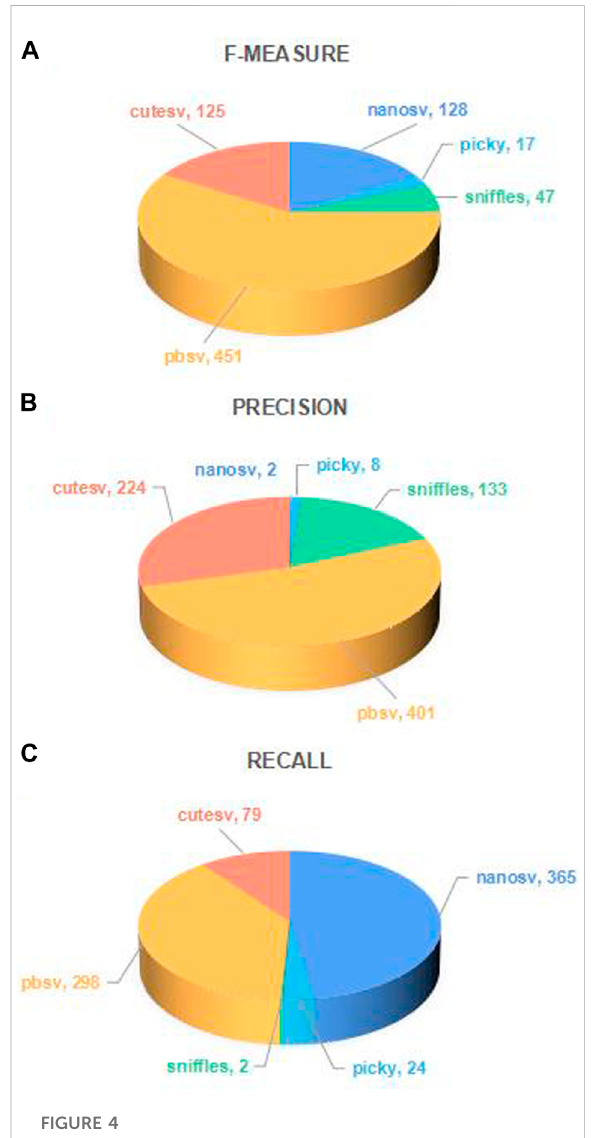
FIGURE 4 Numberoflong-readsequencingdatasetsthateachSVcaller ranks as top 1. The number of times each caller achieved the top one inthethree performance metrics off-measure, precision, and recall for 768 long-read sequencing datasets was calculated in (A) , (B) , and (C) . In each sub fi gure, the sectors of different colors represent different callers, and the sector ’ s size indicates the proportion of different callers achieving the top 1. The number marked in each sector is the number of long-read sequencing datasets on which the performance of the SV caller in terms of the performance evaluation metric value ranks top 1.